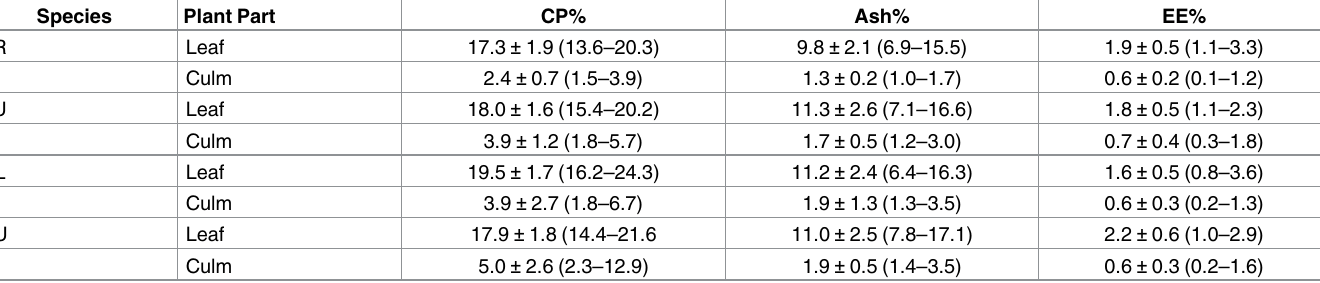
Table 1. Crude protein (CP), ash, and ether extractable fat (EE) in leaf and culm for four Phylostachys bamboo species. P . aurea (AR), P . aureosul- cata (AU), P . glauca (GL), and P . nuda (NU).